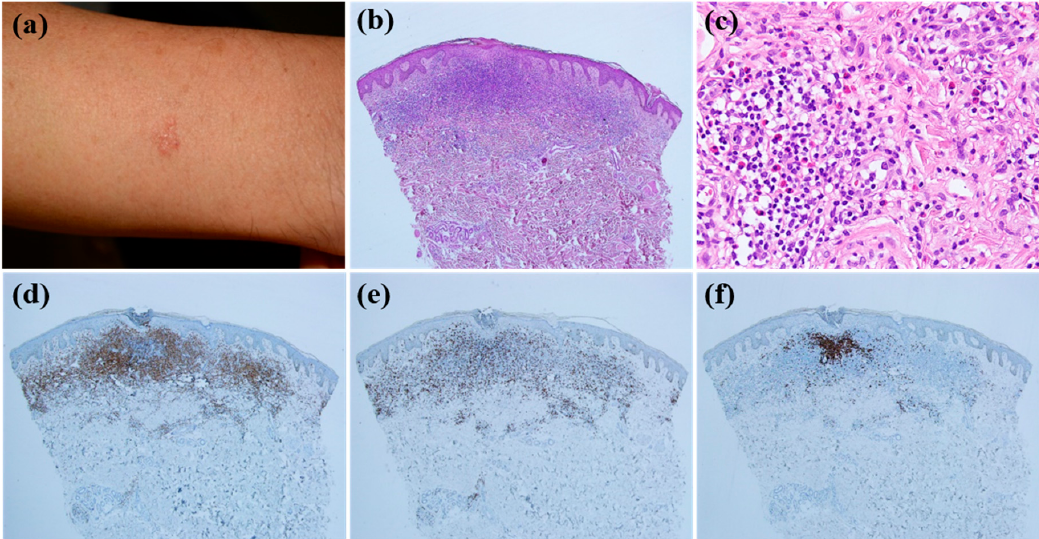
Figure 3. The clinicopathological characteristics of arthropod-bite reaction; ( a ) solitary erythematous papule was noticed on the patient’s forearm. ( b ) Histopathological examination reveals lymphocytic infiltration mostly on the upper dermis. ( c ) Numerous eosinophils were observed. (b: Hematoxylin- eosin stain; magnification: ×40 c : Hematoxylin-eosin stain; magnification: ×200). Lymphocytes showed positive stains for CD4 ( d ) and CD8 ( e ) and weak positive staining for CD20 ( f ) (×40).